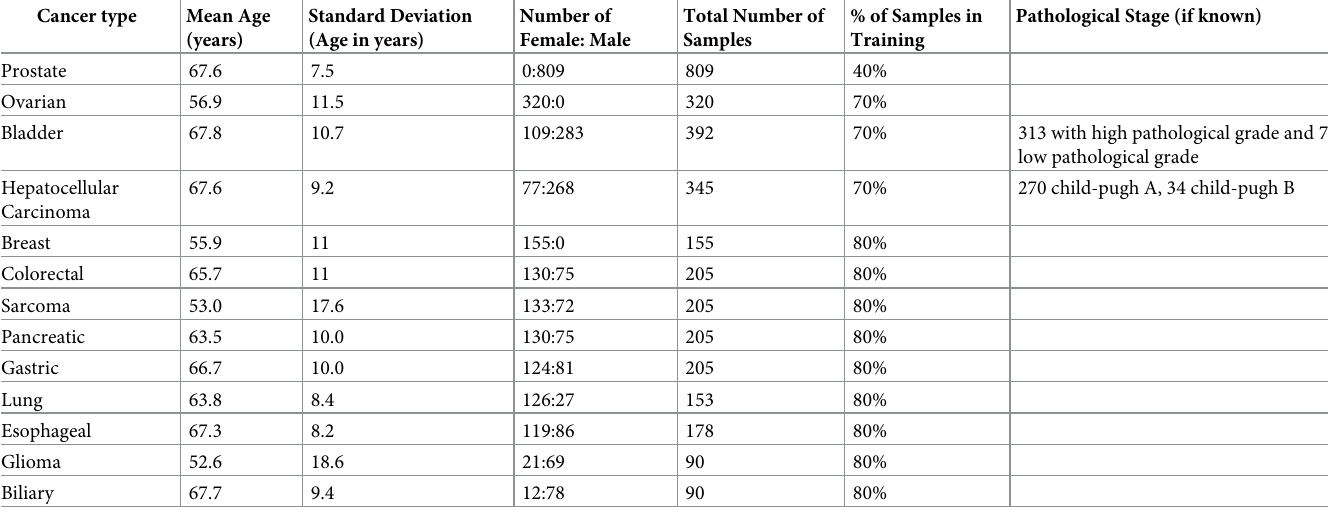
Table 1. Clinical summary for cancer samples.